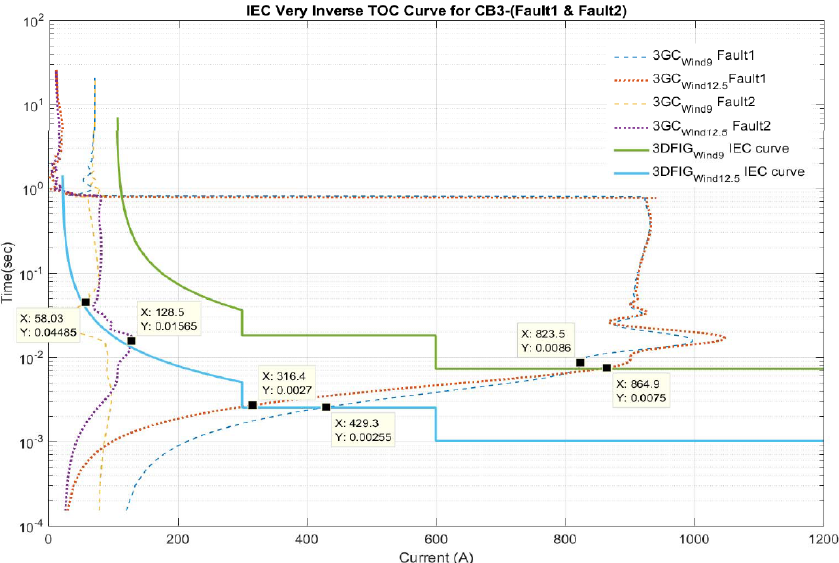
Figure 5. Unresponsive TOC curve for fault at different locations due to grid-connected/islanded mode.